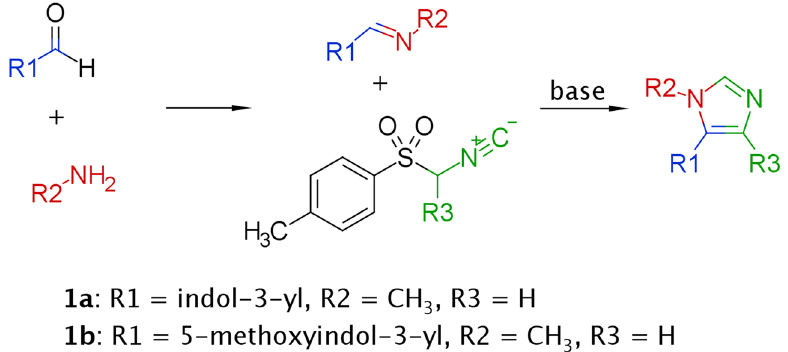
Figure 1. Van Leusen imidazole